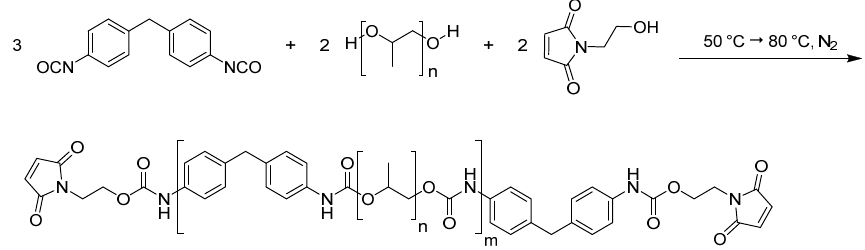
Figure 2. Reaction scheme for the preparation of the maleimide prepolymer. The product was obtained in the form of a clear, yellow, and viscous polymer.